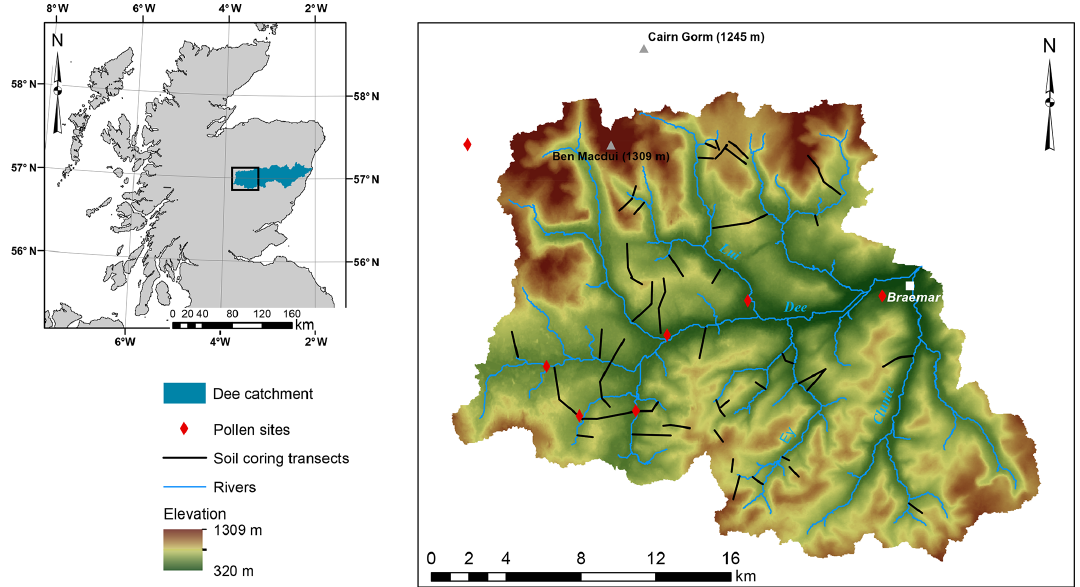
Figure 1. Location of the Upper Dee area, with an indication of the hillslope transects and the pollen sites used for the land cover reconstruc- tion.